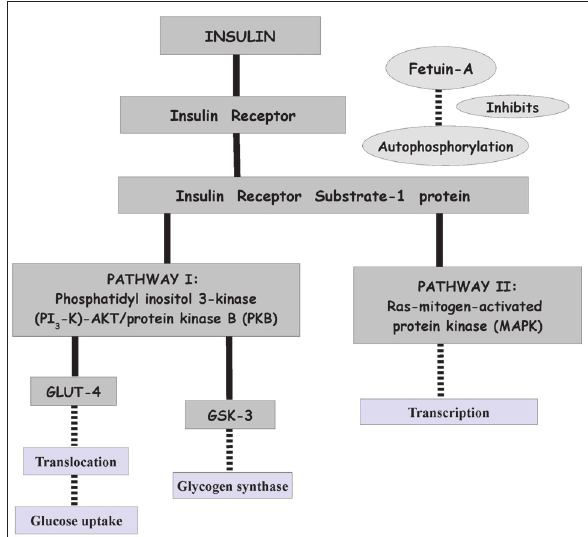
Fig. 1. The action of insulin receptor. Two main pathways: the phosphatyl inositol 3-kinase (PI3-K)-AKT/protein kinase B (PKB) and the Ras-mitogen-activated protein kinase (MAPK) pathway. GLUT4- glucose transporter-4; GSK-3- glycogen synthase